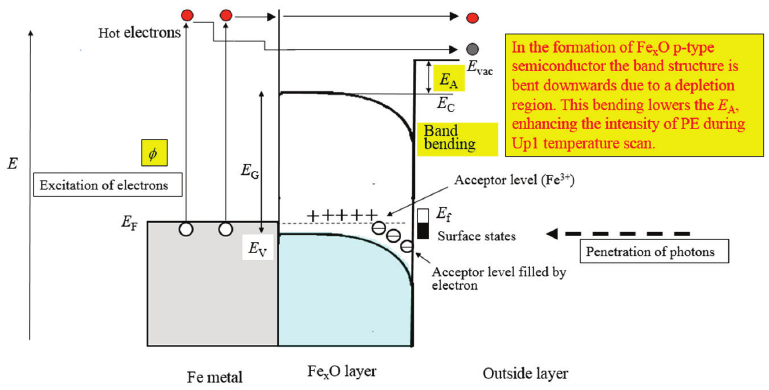
Figure 18. Band model of the energy diagram proposed for the Fe x O p-type semiconductor only, although the effect of the adjacent oxide layer of Fe 3 O 4 is not clear. The symbols E F , E f , E vac , E V , E C , and E A are the Fermi levels of the metal and Fe x O layer, the vacuum level, the top level of the valence band and the bottom level of the conduction band of the Fe x O layer, and the effective electron affinity, respectively. Two types of emitted electrons (hot electrons and thermalized electrons) are indicated [7].